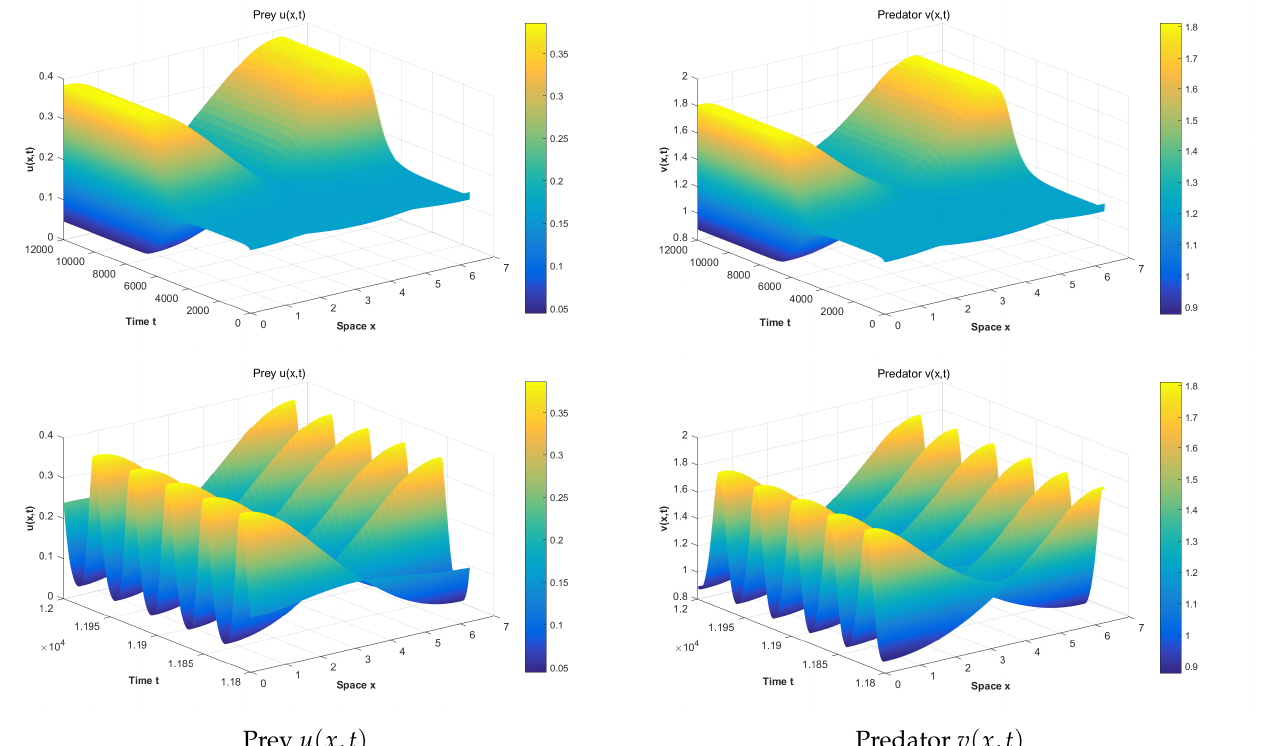
Figure 5. The numerical simulations of system (2) with d = 0.7 and τ = 8. The time scale of the